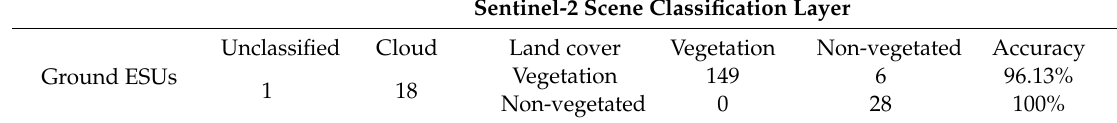
Table 2. The evaluation results of vegetation and non-vegetated pixel identifications in the scene classification layer from Sentinel-2 surface reflectance products based on the investigations of ground